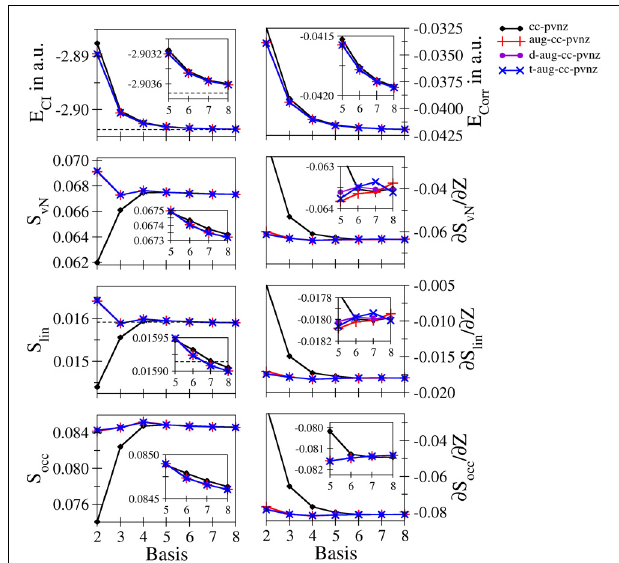
FIGURE 1 | Total and correlation energy E CI and E corr in atomic units; von Neumann S vN , linear S lin and occupation number S occ entropies and their derivative with respect to the nucleic charge Z obtained for Helium at the FCI level using different basis sets.